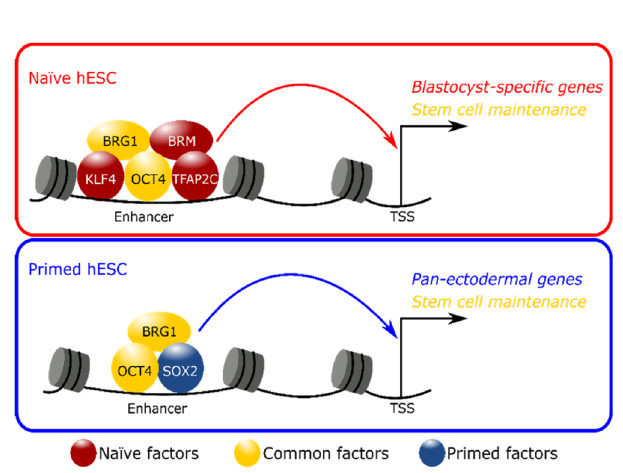
Fig. 8 Model of enhancer regulation by common (OCT4, BRG1) and state- speci fi c TFs and chromatin remodelers in naïve and primed hESCs. In naïve hESCs OCT4 regulates enhancers of blastocyst-speci fi c and stem cell maintenance genes together with the BAF ATPases BRG1 and